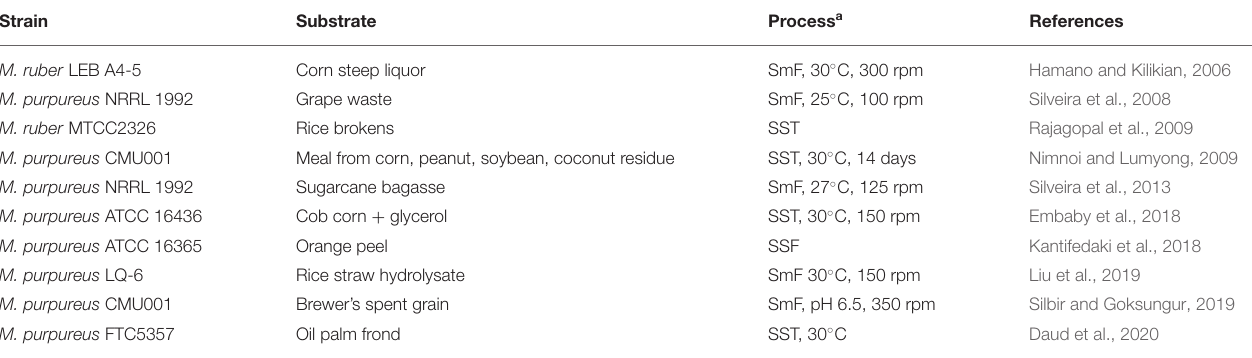
TABLE 1 | Agro-industrial by-products used to produce orange and red pigments from Monascus strains. Strain